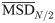
Subdiffusive behavior of chromatin loci.(A) Loci- and time-averaged MSD generated from a single time trajectory in a log-log plot (Inset displays the time-averaged MSD for individual loci, color-coded by a normalized monomer index i/N.). (B) Time-averaged MSD of the midpoint monomer MSD¯N/2, and the center of mass of the whole chain MSD¯com in a log-log plot. The horizontal dashed line labels the mean square end-to-end distance 〈Ree2〉 (= 62.7 ± 0.9 a2) of the chromatin chain. Conversion to the physical time can be made using τBD ≈ 50 ms.